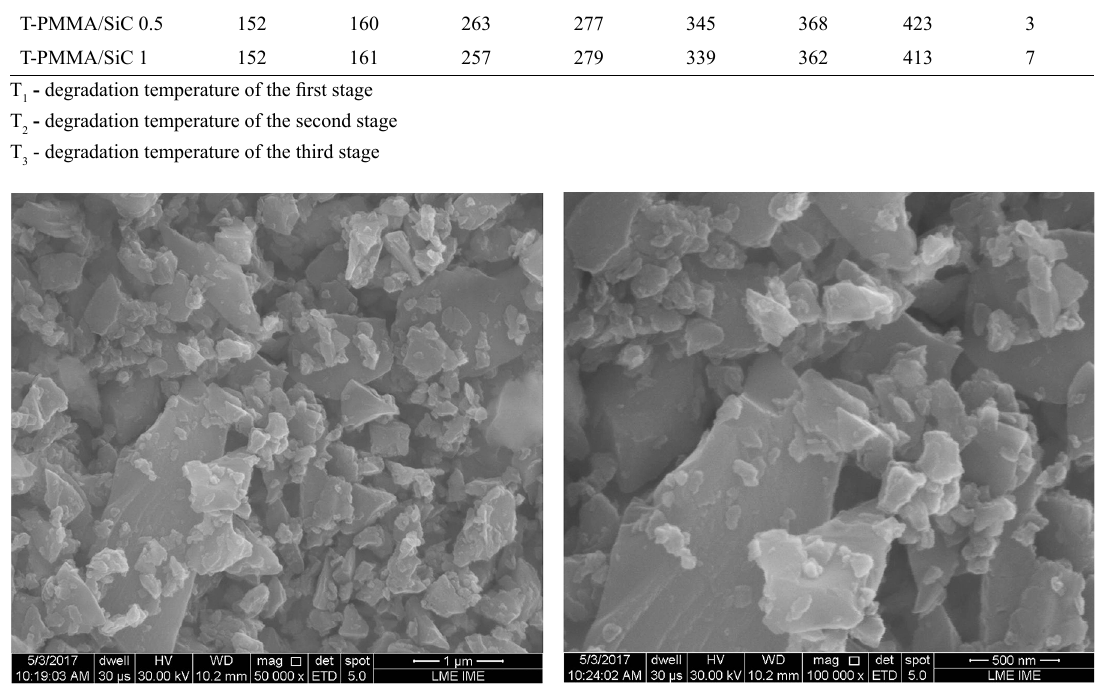
Figure 5. FEG-SEM images of the SiC particles, (5a) SiC particle images with 1µm and (5b) SiC particle images with 500nm scale